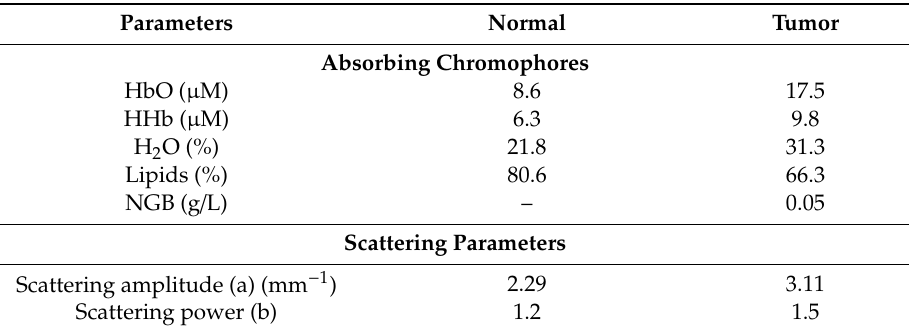
Table 1. Normal versus tumor parameters used for simulations [37].